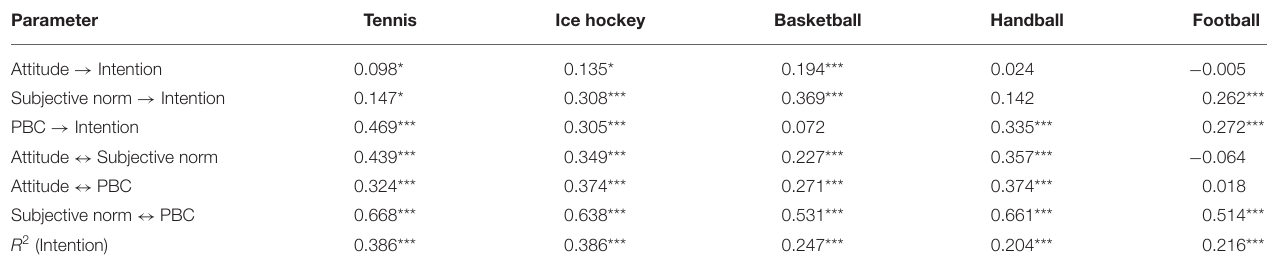
TABLE 6 | Standardized regression coefficients, correlation coefficients, and explained variance for the structural equation models by type of sport.